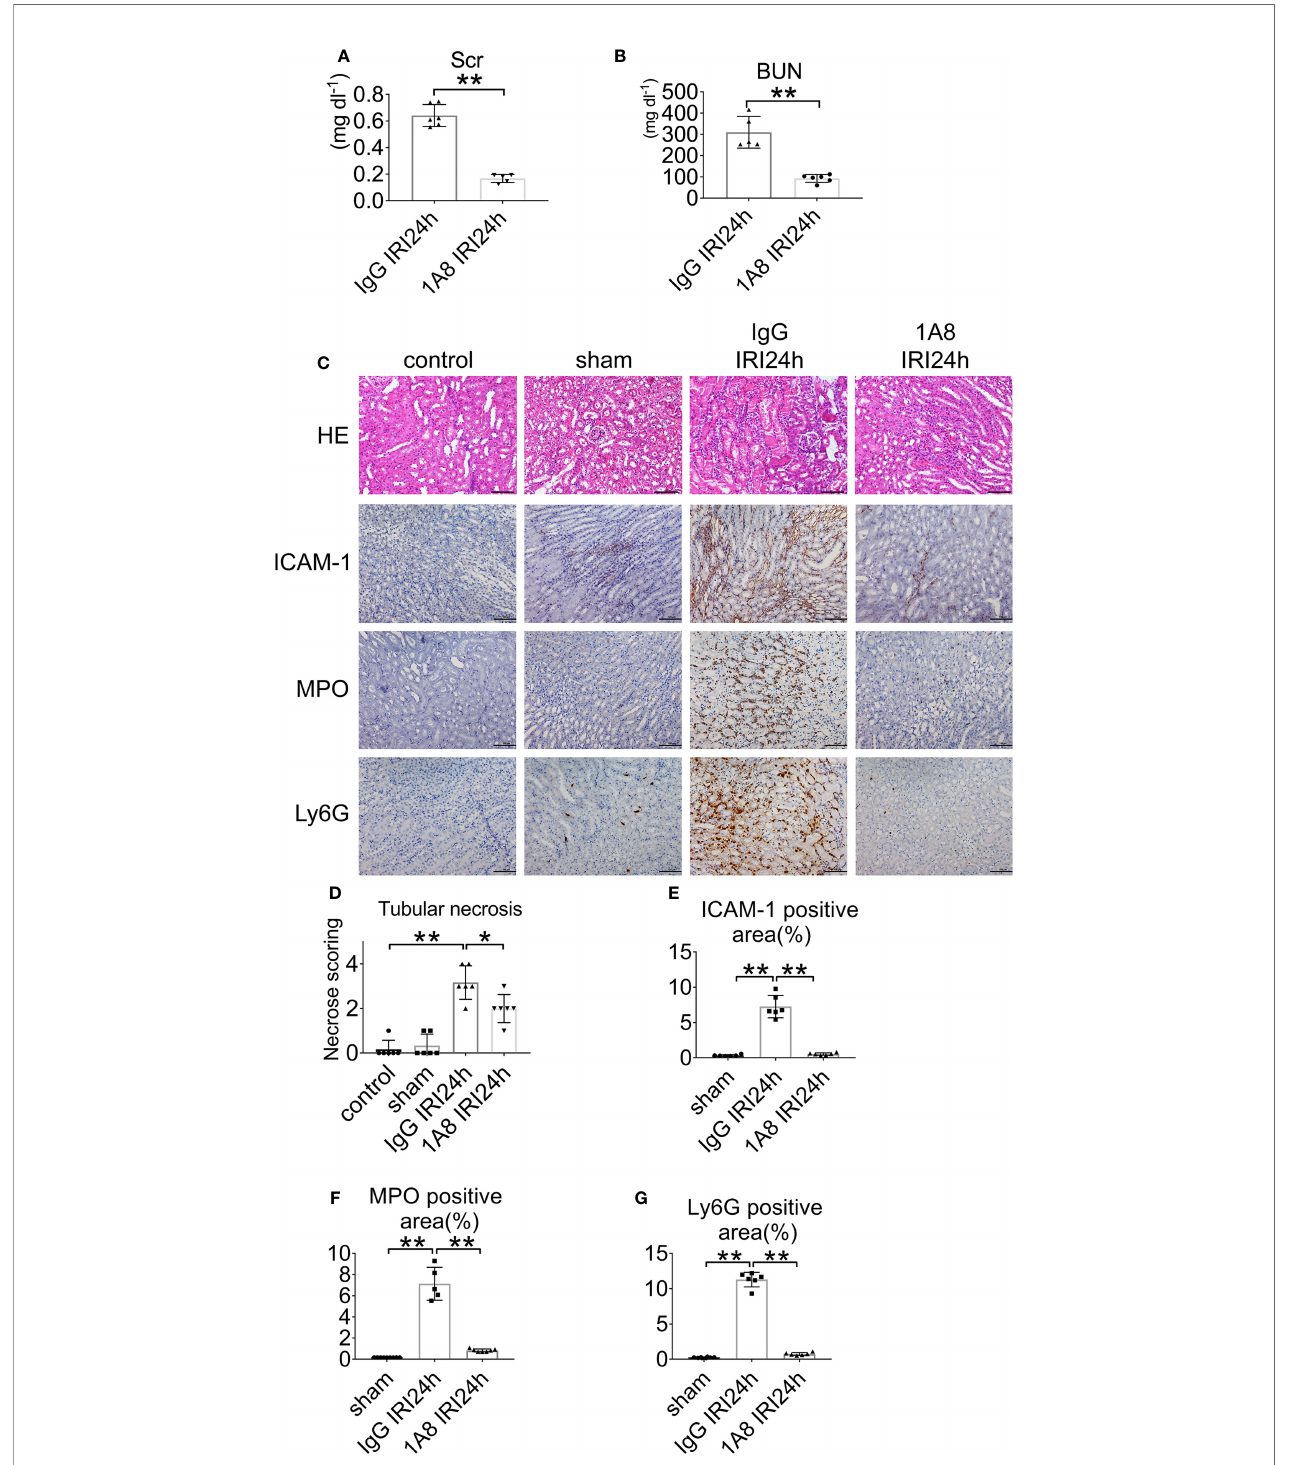
FIGURE 3 | Neutrophil depletion preserves renal function in IRI mice. (A) Serum creatinine, and (B) urea nitrogen of WT mice injected with 1A8 or IgG, n = 5 – 6/ group. (C) Histology of IRI kidney in the indicated treatments. HE staining (Row 1). ICAM-1 immunohistochemistry (Row 2). MPO immunohistochemistry (Row 3). Ly6G immunohistochemistry (Row 4). Scale bar = 200 m M. n = 5 – 6/group. The percentage of positive neutrophil staining in 10 non-overlapping fi elds was quanti fi ed using Image J software. (D) Score for histopathology of tubular damage after renal IRI using HE-stained renal tissue sections. (E) ICAM-1-positive area. (F) MPO- positive area. (G) Ly6G-positive area. *P < 0.05, **P < 0.01. Data are presented as mean ±